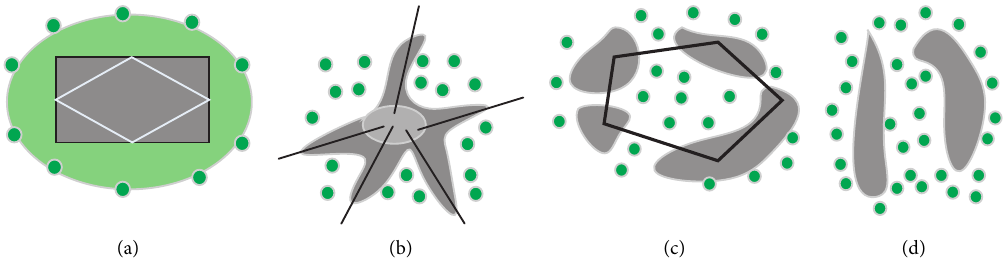
Figure 2: Different city types and green space distributions: (a) core type; (b) star stye; (c) satellite type; (d) linear